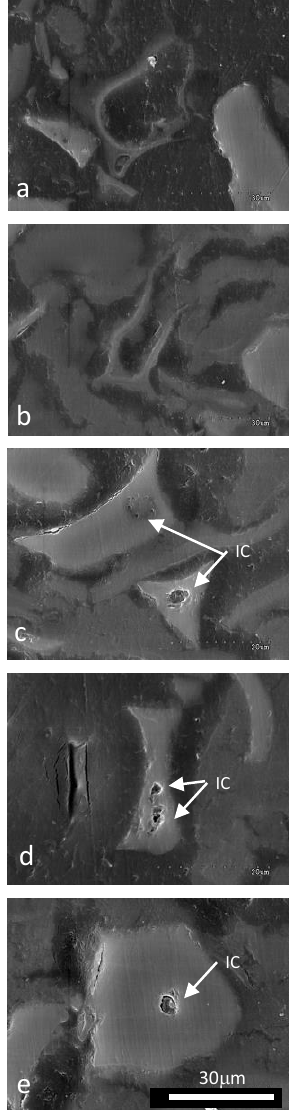
Figure 2. SEM images of the thin section of the TD-F-L wheat phytolith types including silica sheets (a, b) , and GSC phytoliths of the rondel type (c, d, e) . GSC types show micrometric internal cavities